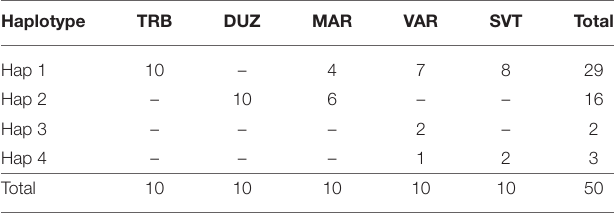
TABLE 4 | Distribution and frequency of COIII haplotypes of S. maximus populations.